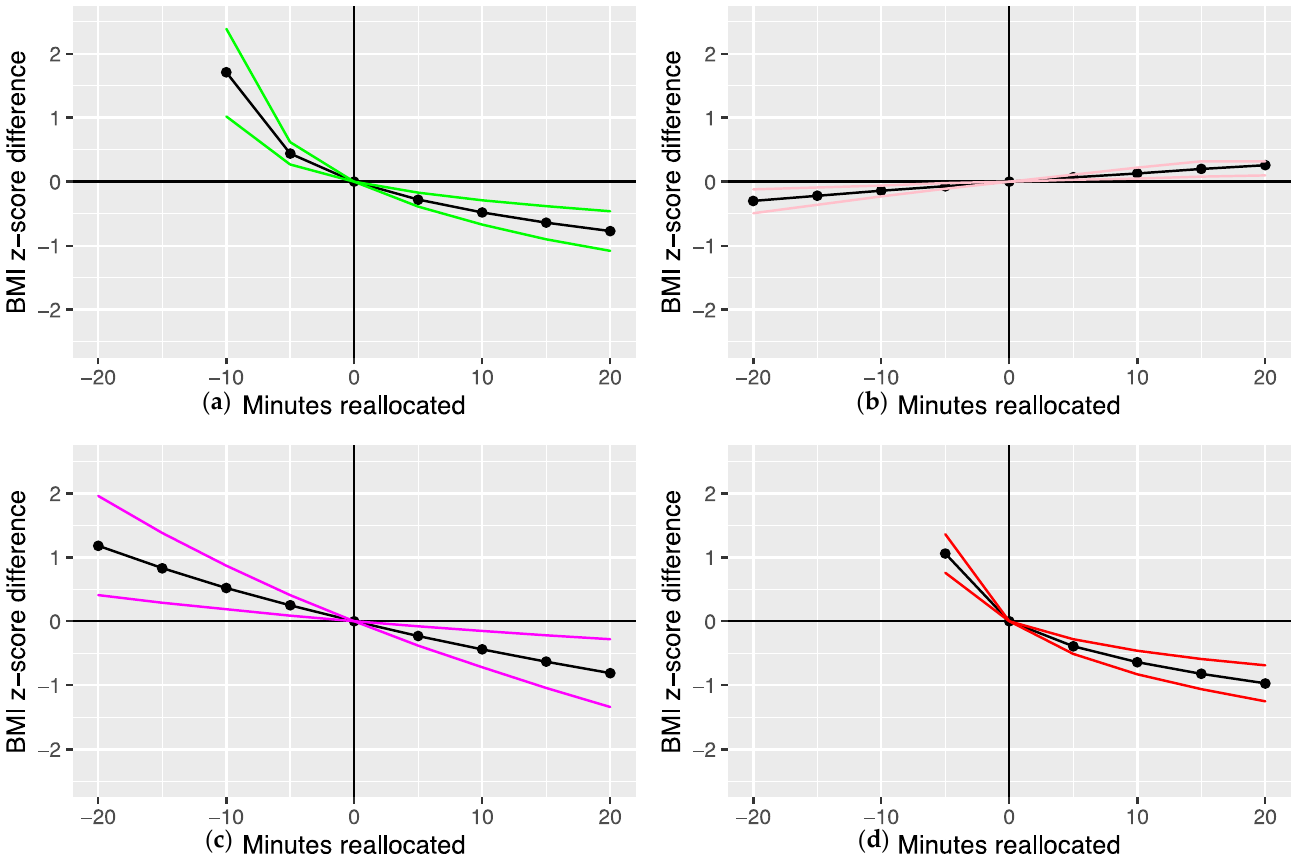
Figure 1. ( a – d ) Predicted differences in BMI z-score for the time reallocations between the most dominant intensity bands and the remaining intensity bands. Note: ( a ) ≥ 700 mg intensity band (boys); ( b ) 50–100 mg (girls); ( c ) 100–150 mg (girls); ( d ) ≥ 700 mg (girls). Note: coloured lines represent the lower and upper boundaries of the 95% confidence intervals.